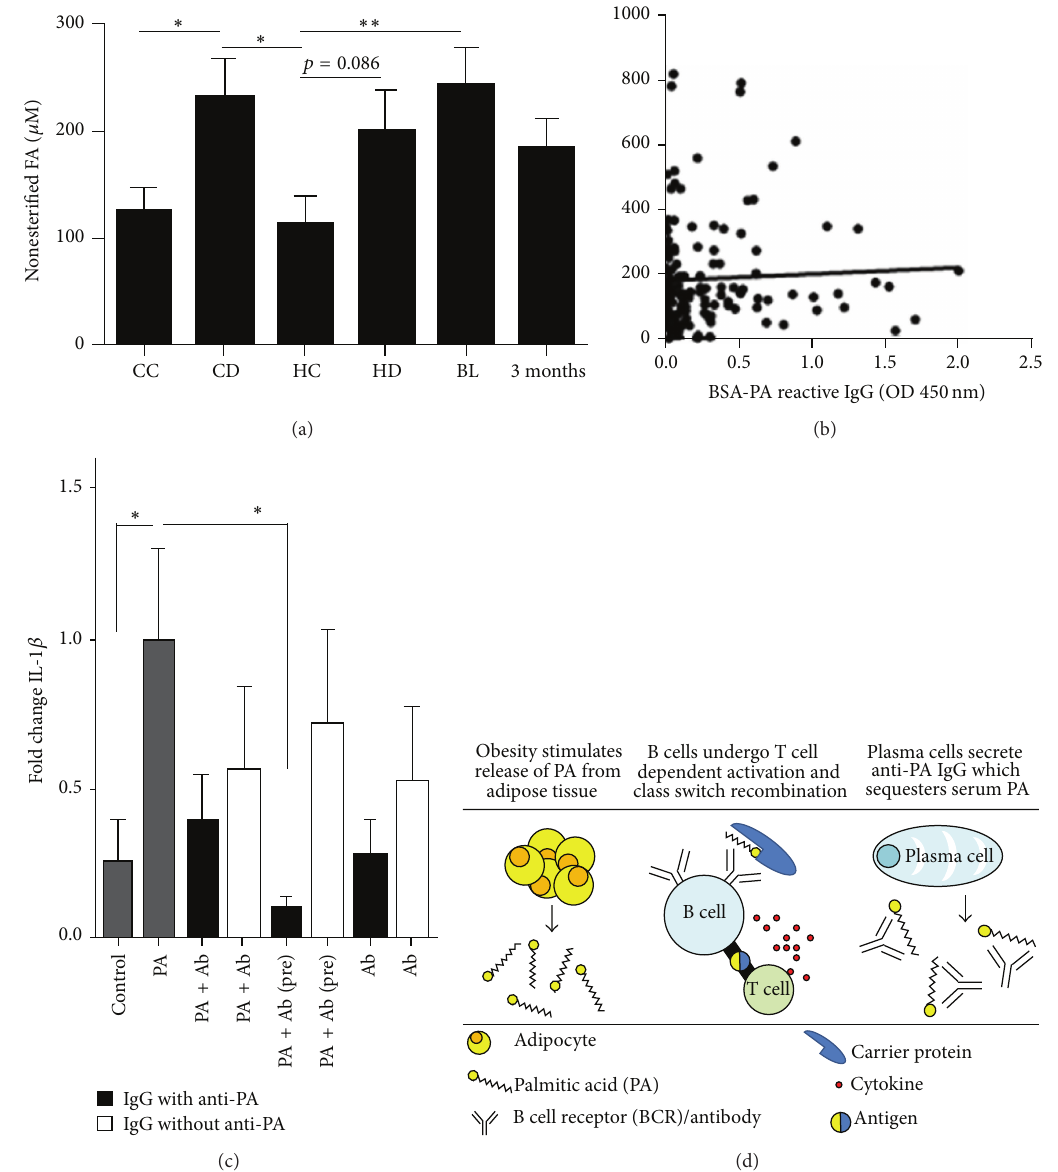
Figure 6: Serum nonesterified serum FA. (a) Bar graph of serum nonesterified FA among diabetic and nondiabetic cohorts. CC = Caucasian control; CD = Caucasian diabetic; HC = Hispanic control; HD: Hispanic diabetic. Data was analyzed by Mann-Whitney. ∗ 𝑝 < 0.05 , ∗ 𝑝 < 0.01 . (b) 𝑋𝑌 plot of anti-LCSFA IgG and nonesterified serum FA for all serum samples in this study. (c) Anti-LCSFA IgG neutralizes PA-induced IL- 𝛽 secretion from DCs in the presence of BSA. Monocyte derived dendritic cells from healthy patients were cultured with 150 𝜇 M PA (in 1: 1 ratio with BSA) in the presence of a mixture of IgG antibody isolated from 5 En Balance participants who tested positive for anti-LCSFA IgG (black bars) or in the presence of a mixture of IgG antibody isolated from 2 En Balance participants who tested negative for the antibody after the 3-month intervention (white bars). PA + Ab (pre) indicates dendritic cells that were treated with PA preabsorbed for 2 hrs with total IgG from the two groups described. After 24 hrs, media from the cell cultures were analyzed by cytometric bead array for IL-1 𝛽 . Data was analyzed by one-way ANOVA. ∗ 𝑝 < 0.05 . (d) Illustration of the potential mechanism for the generation of anti-LCSFA IgG.